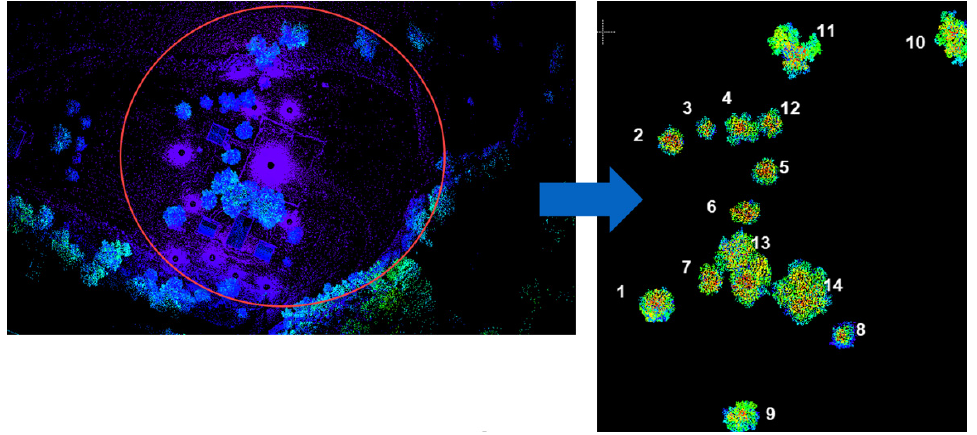
Figure 7. Examples of sampling isolated amorphous objects from the point cloud data, where the numbers represent identifiers of amorphous objects.